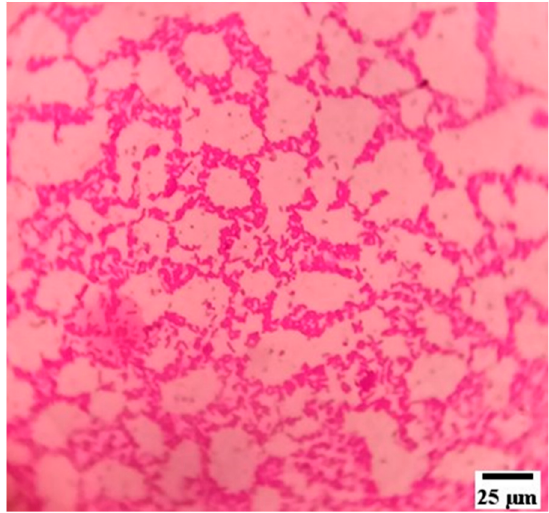
Figure 18. Microscopic image of the bacterial solution (Mag: 1000×).